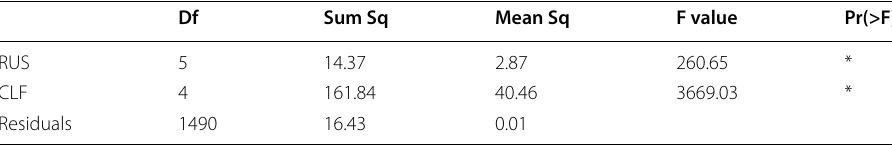
*Indicates value is less than 1 × 10 − 4